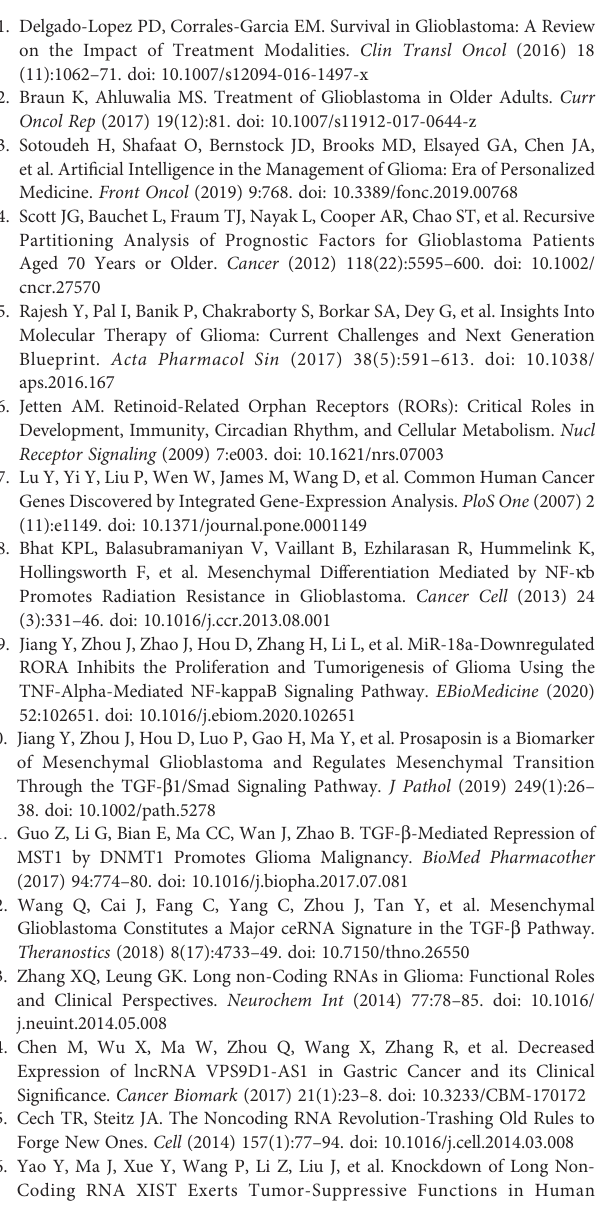
Supplementary Figure 7 | EIF4A3 induced the migration, invasion, and EMT of GBM,and theseinductioneffectswererestrained followingCASC2overexpression. (A, B) Representative migration assay and Transwell assay showing the migration ratesandinvasionratesofGSC2CwithEIF4A3overexpression,whilereversed after CASC2 overexpression. Scale bar = 100 m m. Representative microphotographs showing the morphological changes in EIF4A3-overexpressed GSC2C, while also reversed after CASC2 overexpression. Scale bar = 50 m m. (C, D) Representative immuno fl uorescence staining and western blotting showing the changes in E-cadherin, vimentin, and N-cadherin in GSC2C after EIF4A3 overexpression, while reversed after CASC2 overexpression. Scale bar = 50 m m. EV, empty vector; OE, overexpression; NC, negative control; KD, knockdown. All data are expressed